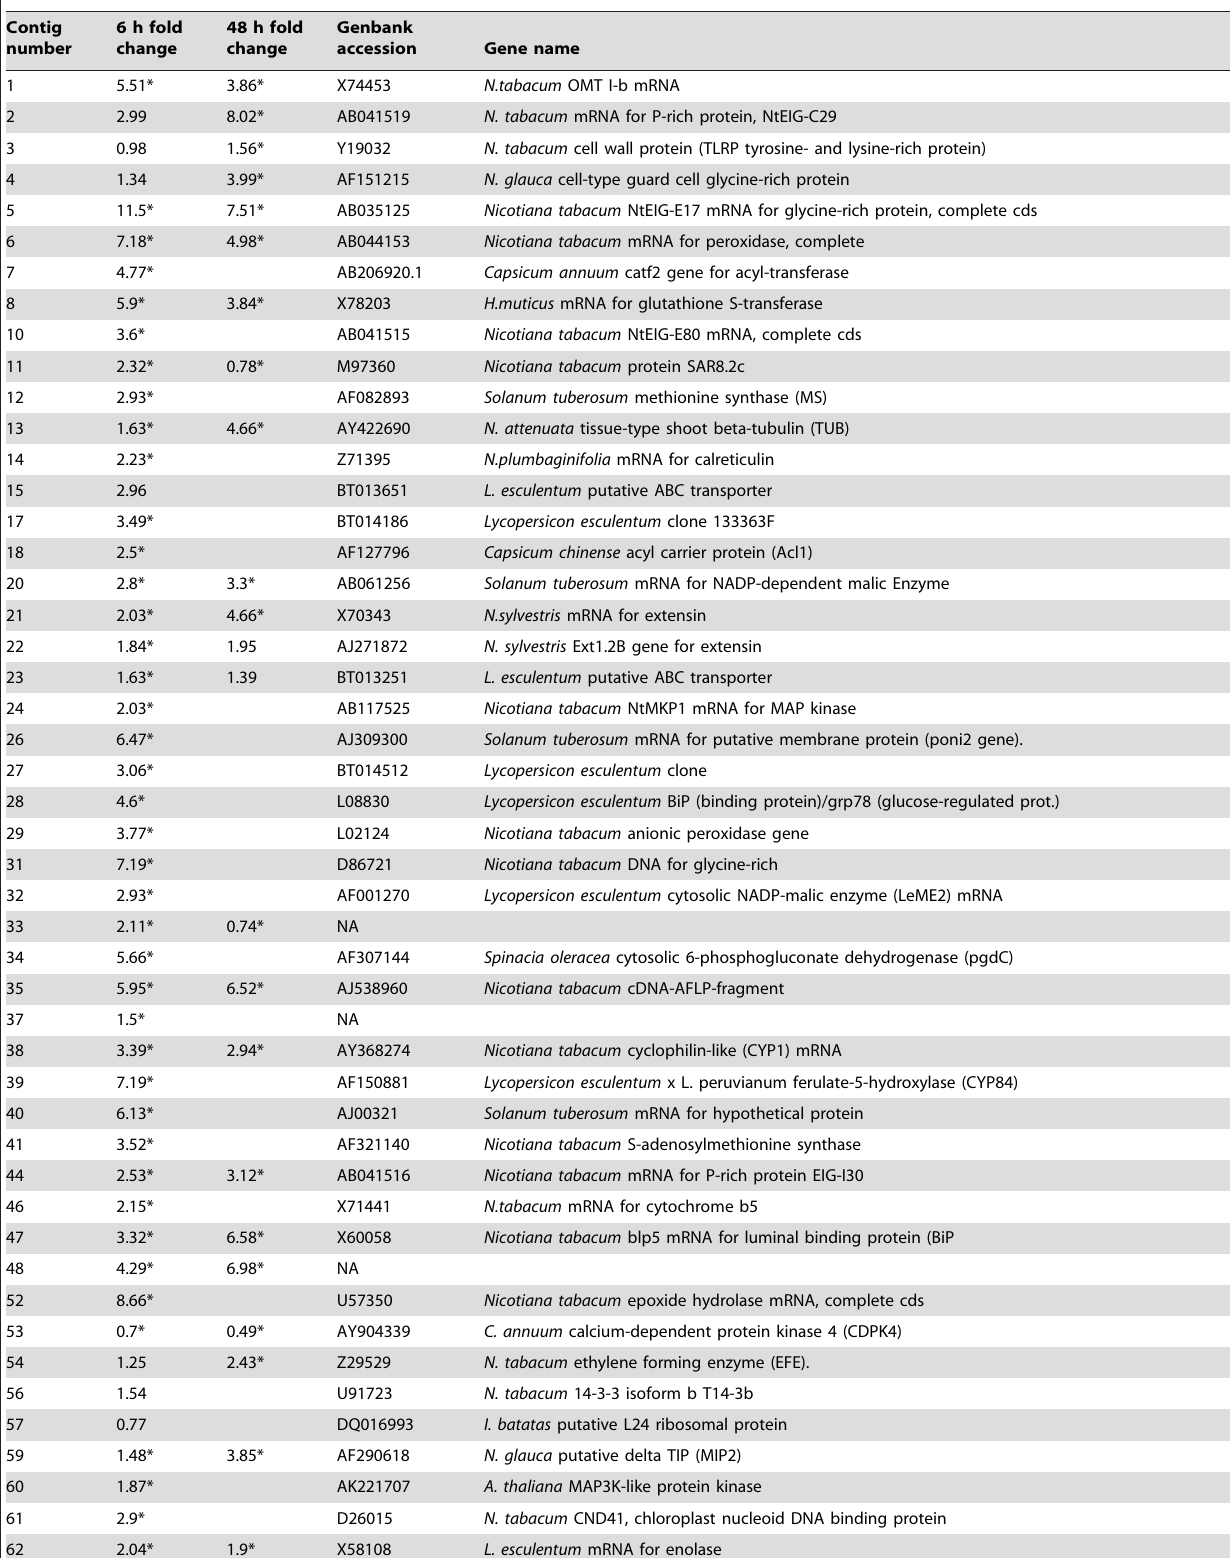
Linear fold changes of PTI-related genes at 6 and 48 hpi measured by